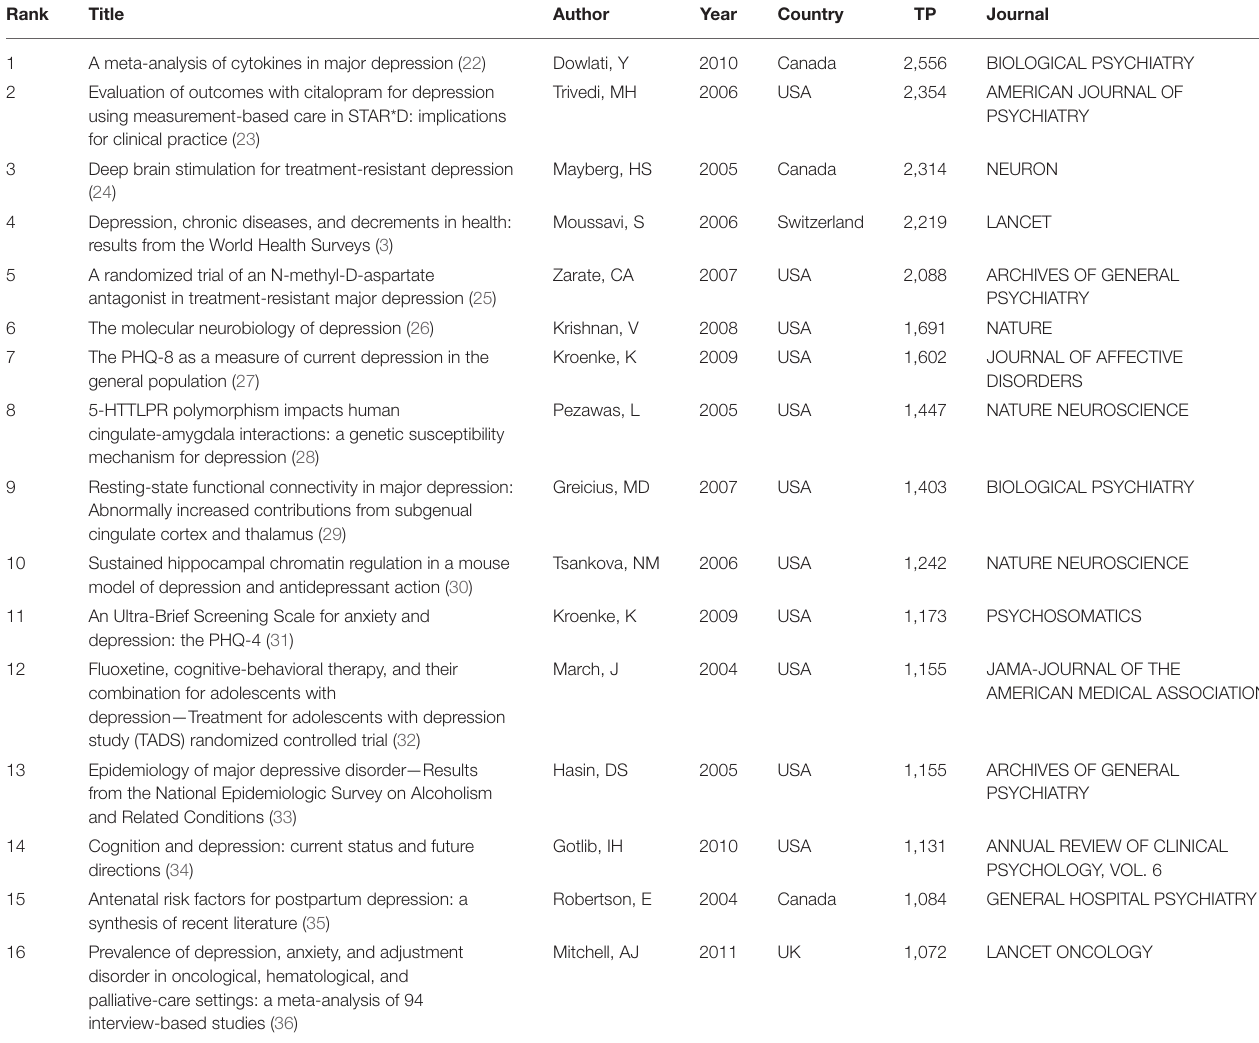
represent the main research directions in the field of depression; they are also the key research directions in this period, and to a certain extent, represent the research hotspots in this period. Burst detection was performed on the keywords, and the 25 keywords with the strongest strength were extracted, as shown in Table 9 . These keywords contain: fluoxetine, community, follow up, illness, psychiatric disorder, dementia, trial, placebo, disability, serotonin reuptake inhibitor, myocardial infarction, hospital anxiety, antidepressant treatment, late life depression, United States, epidemiology, major depression, model, severity, adolescent, people, prefrontal cortex, management, meta- analysis, and expression. The keywords that burst earlier include fluoxetine (2004), community (2004), follow up (2004), illness (2004), and psychiatric disorder (2004), are keywords that imply that researchers focused on themes early in the field of depression. As researchers continue to explore, the study a future research priority. The keywords with the strongest